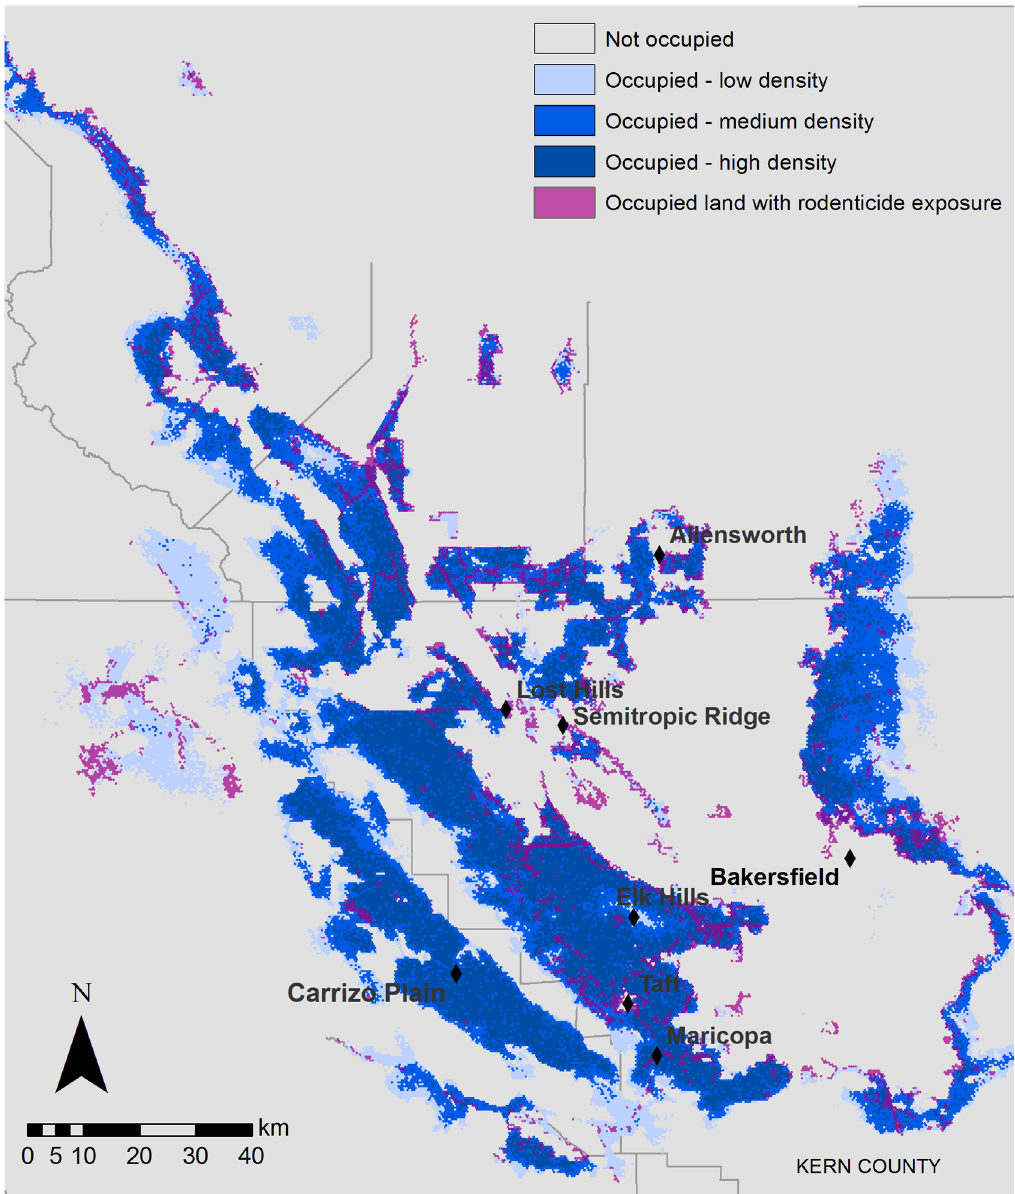
Fig 2. San Joaquin kit fox modeled occupancy overlap with areas of rodenticide use. Source of mapped data are model outputs, created in ArcMap 10.2.